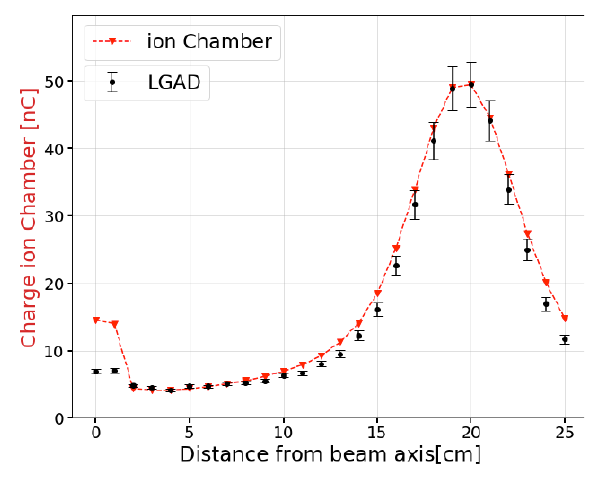
Fig. 8. Comparison between the measurement of the charged ions by the ion chamber (red points) and the measurement using our fast Silicon detector. We note a good correlation between both measurements.